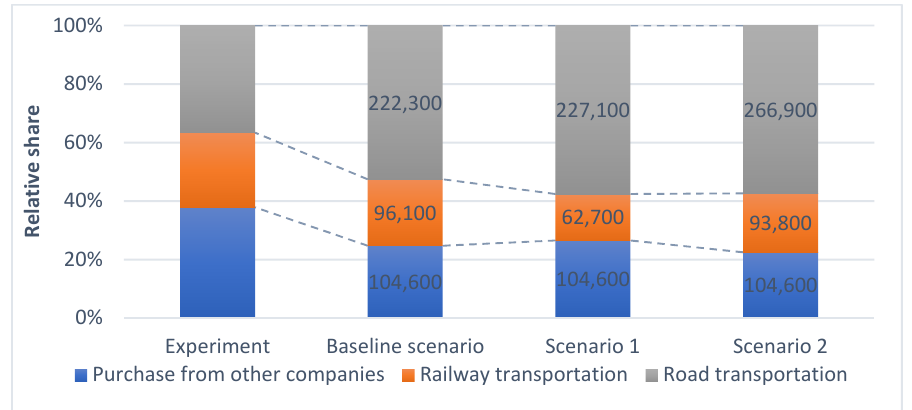
Figure 5. Pine log amounts (m 3 ) by origin and mode of transport to sawmill in experiment and sce- narios.